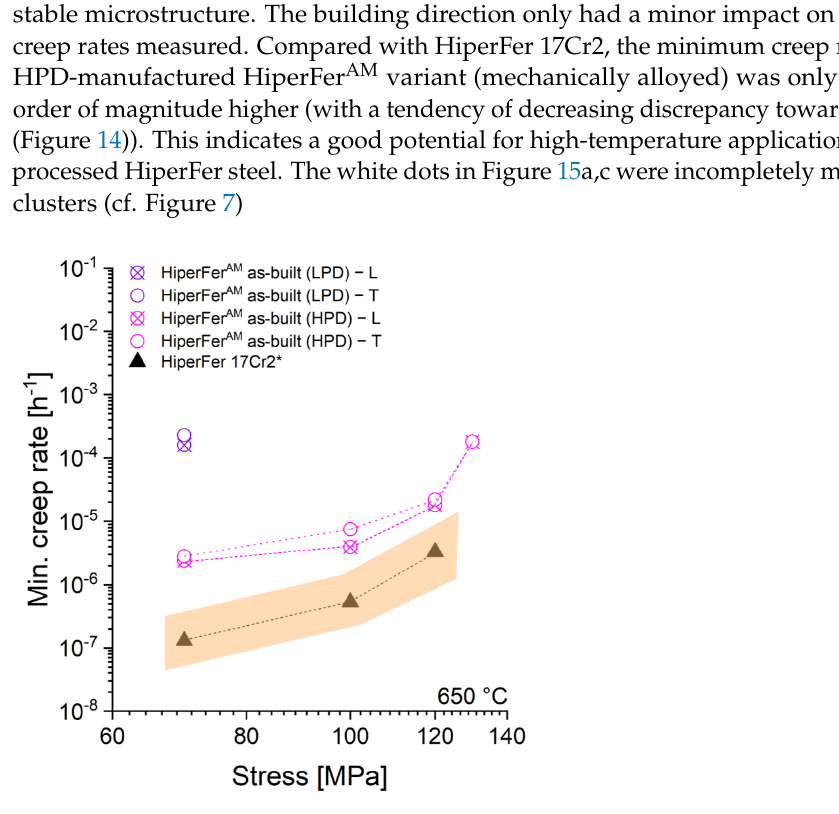
Figure 14. A 650 °C Norton plot of HiperFer AM with respect to the area-specific laser power and build direction in comparison to HiperFer 17Cr2* Data from [13].